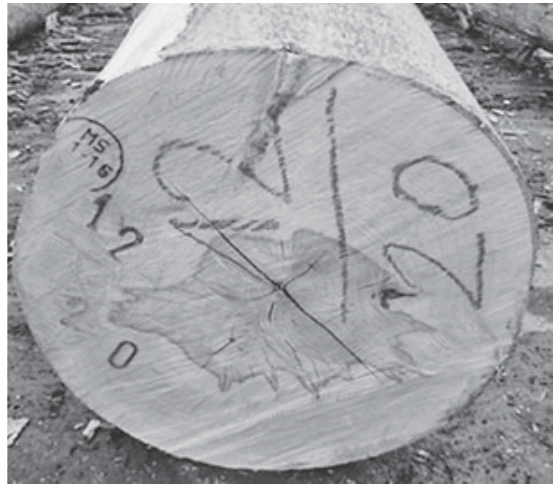
Figure 7 Analyzed log No. 58 Slika 7 . Analizirani trupac broj Figure 5 graphically represents percentages of